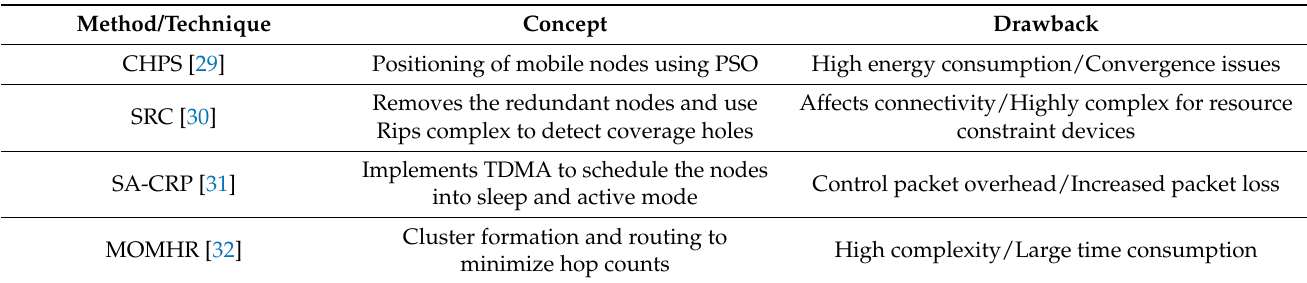
Table 1. Research gaps in previous works.